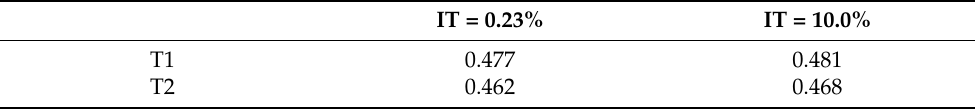
Table 2. Maximum Cp for isolated wind